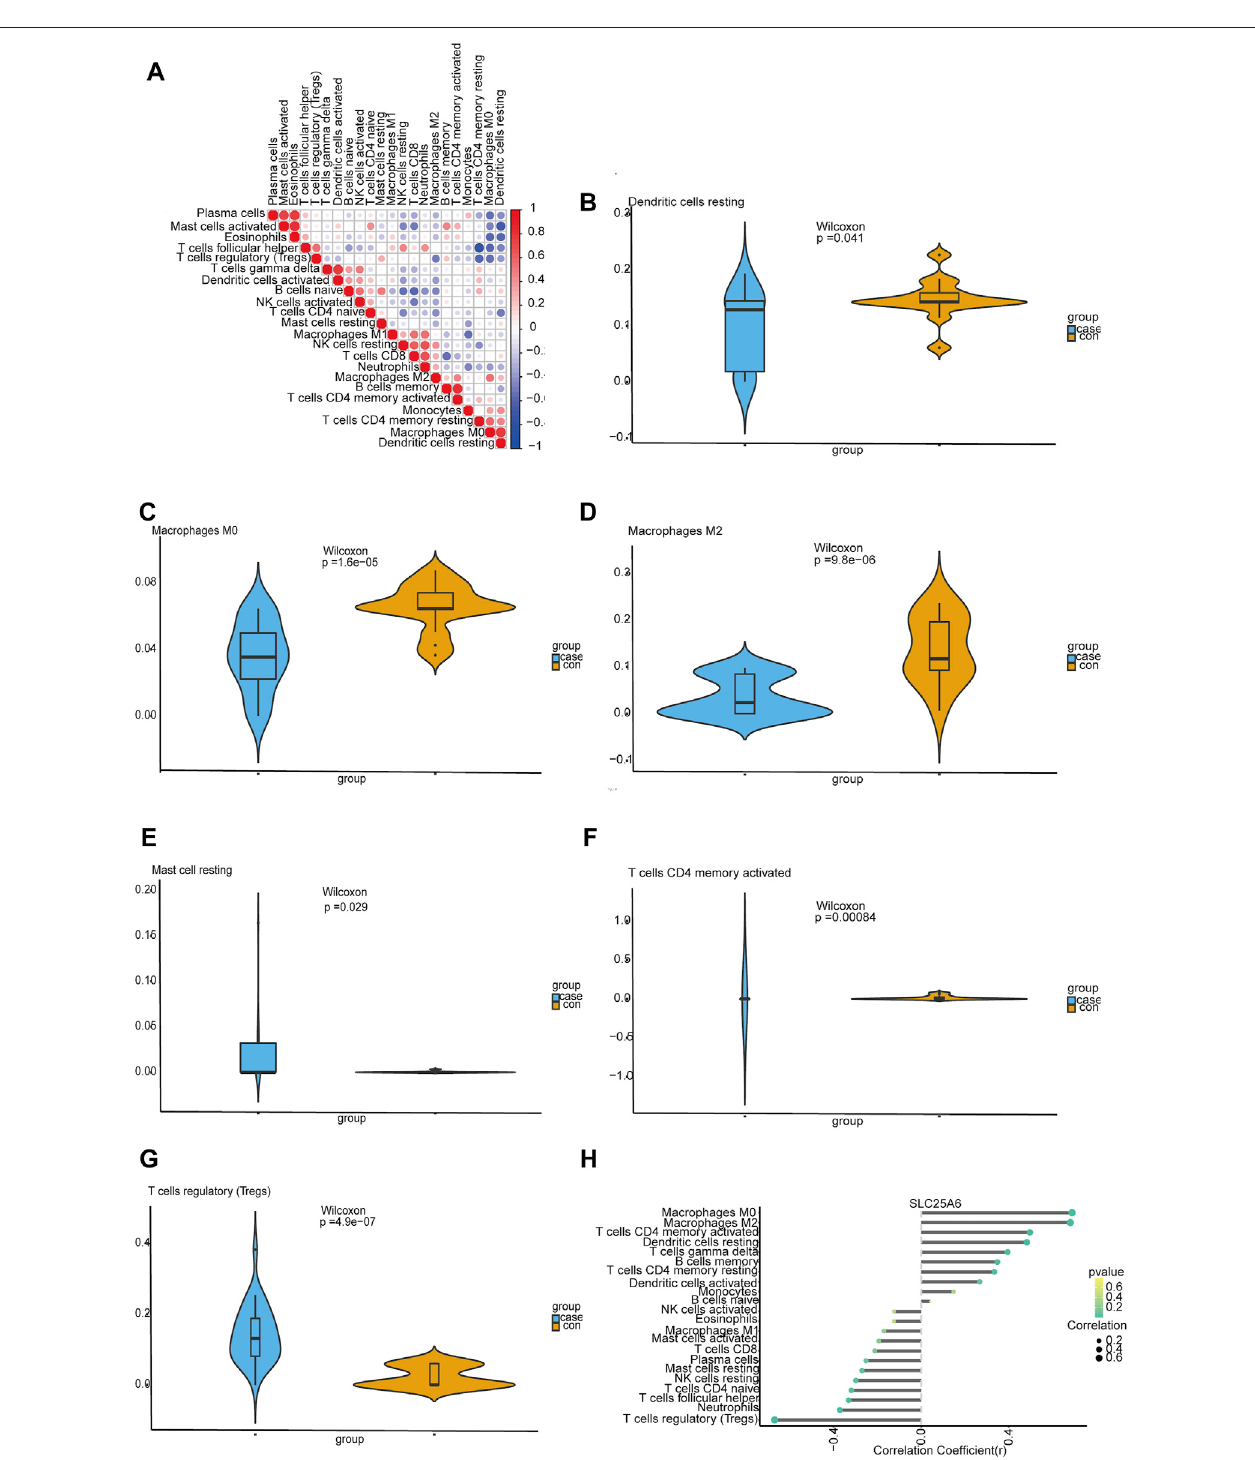
FIGURE 6 | Evaluating and visualizing immune cell in fi ltration. (A) : The correlation heat map of 22 immune cells. The degrees of correlation are re fl ected by the size of the colored square; a positive correlation with the signature is represented by red squares, and a negative correlation is represented by blue squares; the darker the color,thestronger thecorrelation. (B – G) :Violin plots showingimmunecellsthat aresigni fi cantlydifferentbetween normal and TSsamples; theblue violinrepresentsthe TS samples, and the orange violin represents the normal samples. (H) : Correlation between SLC25A6 and the extent of immune cell in fi ltration. The dot sizes represents the correlation strength between genes and immune cells; the larger the dot is, the stronger the correlation. The p -value is denoted by dot color, where the moreintensethegreenis,thesmallerthe p -value,andthemoreintensetheyellowis,thelargerthe p -value.A p -valueof0.05wasconsideredtobestatisticallysigni fi cant.